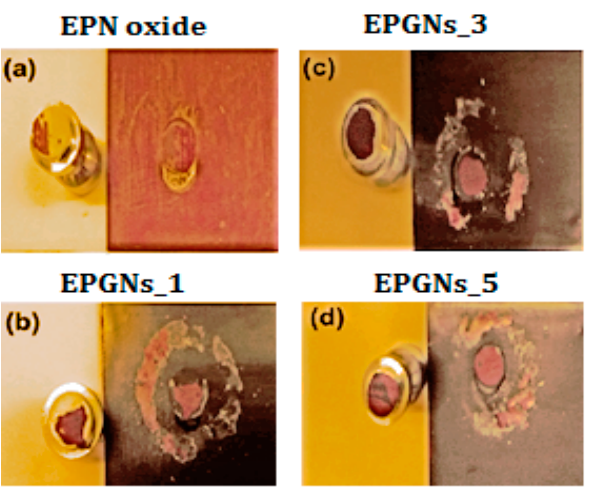
Figure 4. Digital images of adhesion pull off test results in the Verma et al. nanocomposite coating EPN oxide( a ), EPGNs-1 ( b ), EPGNs-3 ( c ), EPGNs- 5( d ) (Adapted with permission from [50]).